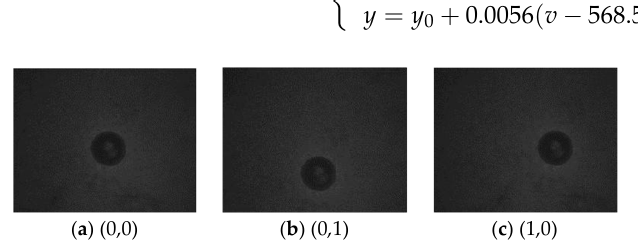
Figure 7. Pictures of marking points taken at different positions.